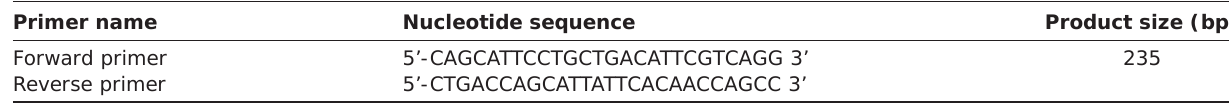
Table-2: List of oligonucleotide primers for detection of sodA gene (Alber et al. , 2004).